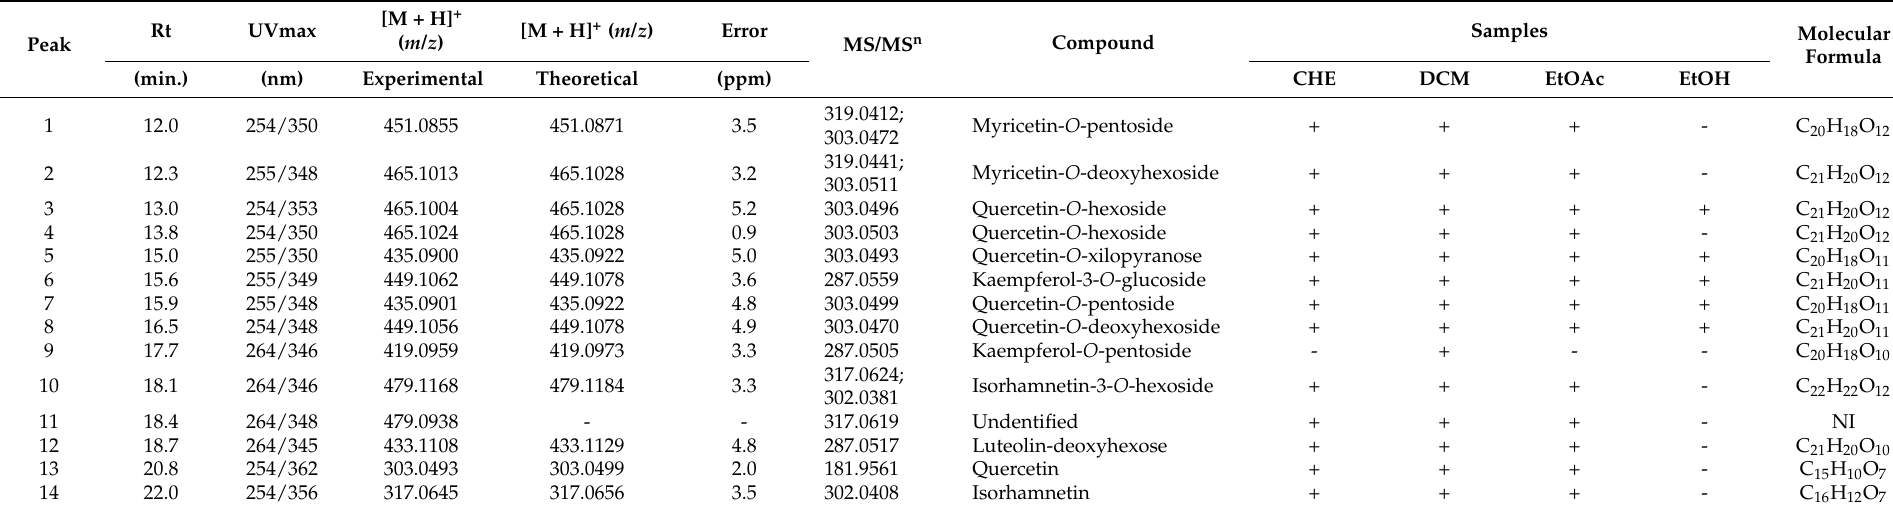
Table 2. Characterization of compounds in crude extract and fractions from Bauhinia holophylla using high-performance liquid chromatography coupled with diode array detector and mass spectrometry (HPLC-DAD-MS) in positive ionization mode. CHE (crude hydroethanolic extract); EtOAc (ethyl acetate fraction); DCM (dichloromethane fraction); EtOH (hydroethanolic fraction). (+) presence and (-) absence. NI = not identified.